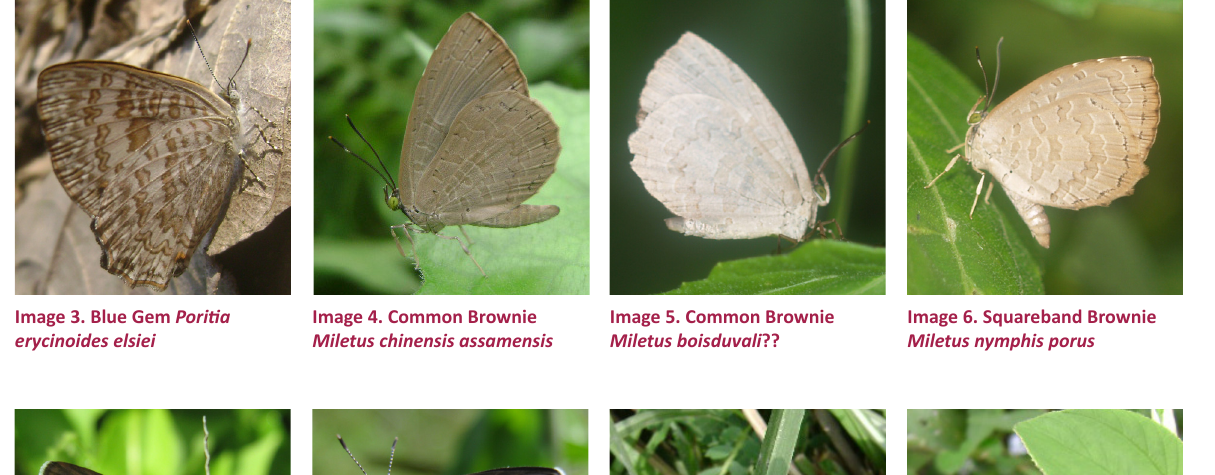
Image 3. Blue Gem Poritia erycinoides elsiei